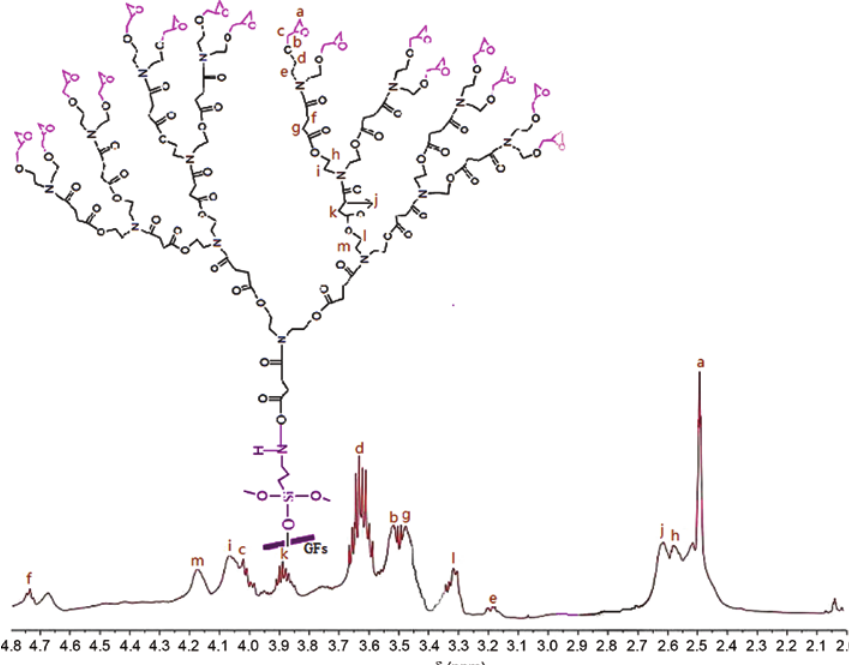
Figure 2: 1 H NMR spectrum of